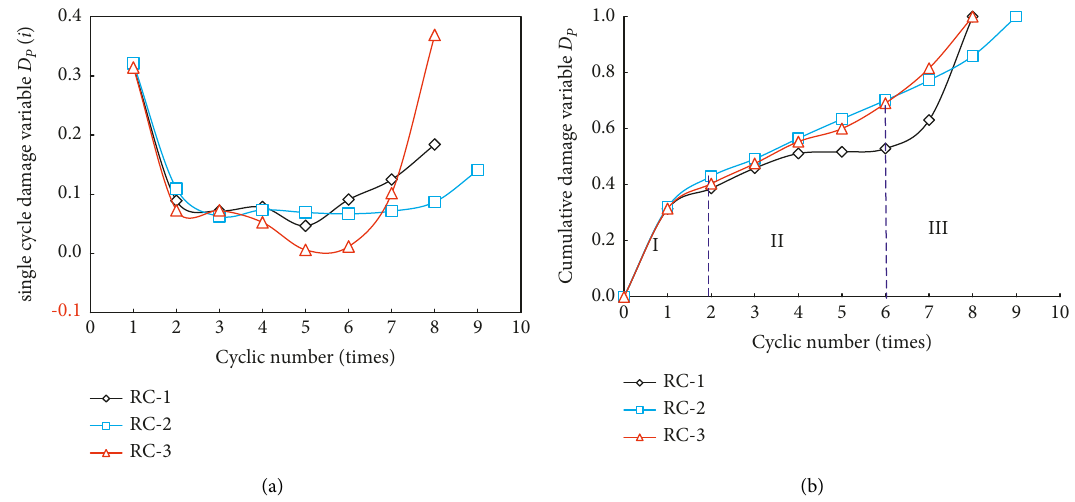
Figure 5: Damage variable curve based on residual deformation: (a) D